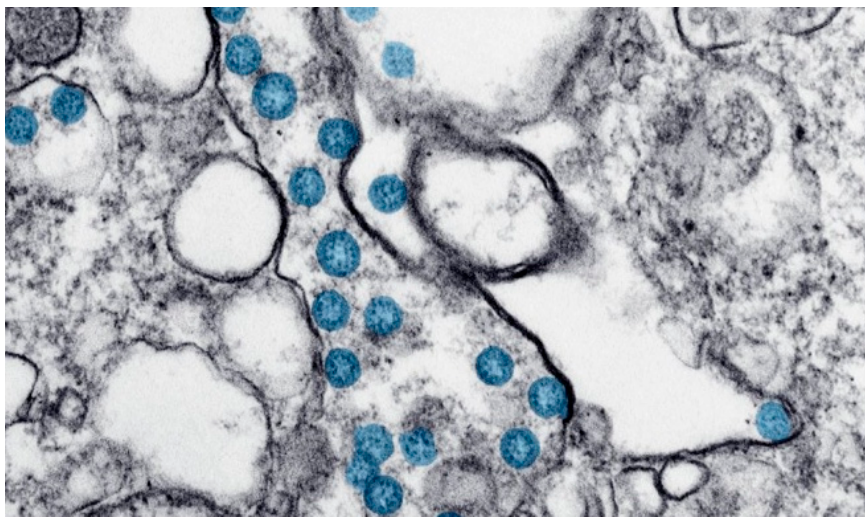
Figure 2. Transmission electron microscope image of SARS-CoV-2 spherical viral particles in a cell [39]. Reprinted (adapted) with permission from the American Chemical Society (2020).